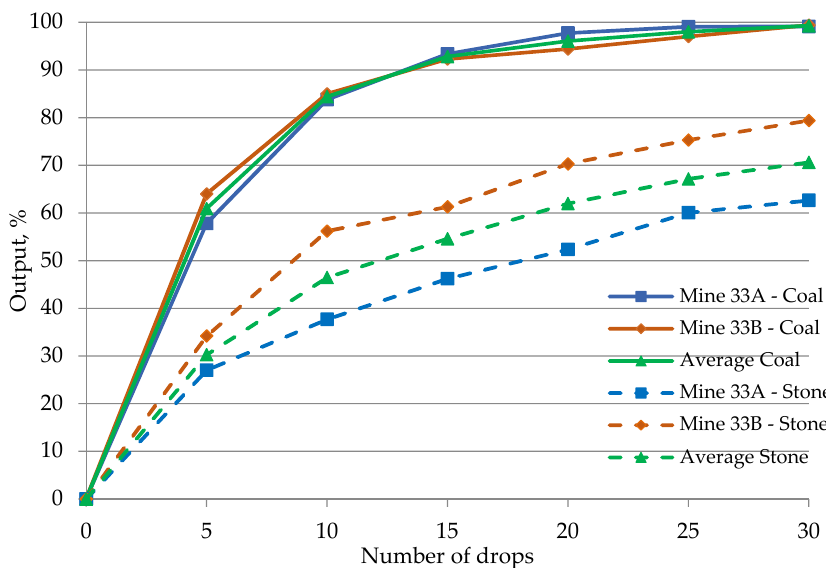
Figure 3. Comparative results of 80-0 mm class output depending on number of drops (type 33) [43].